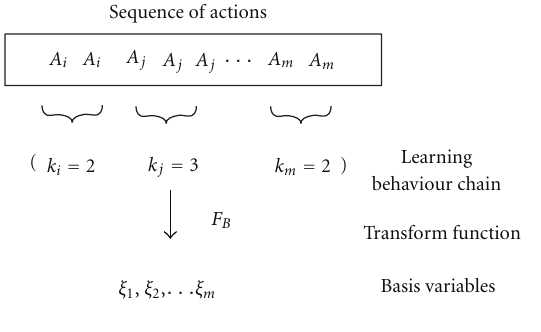
Figure 4: Creating of behavior chain. Table 1: Examples of correlating behavior sequence of actions.